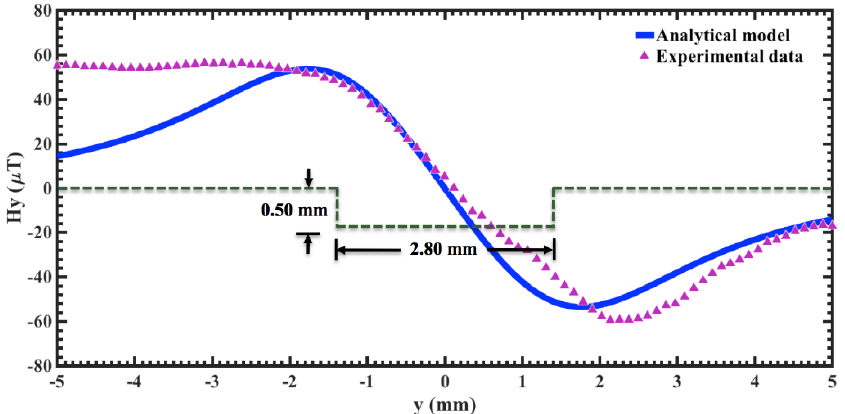
Figure 10. Normal MMM signal of the rectangular defect S3 of the ASTM A-36 steel pipe.